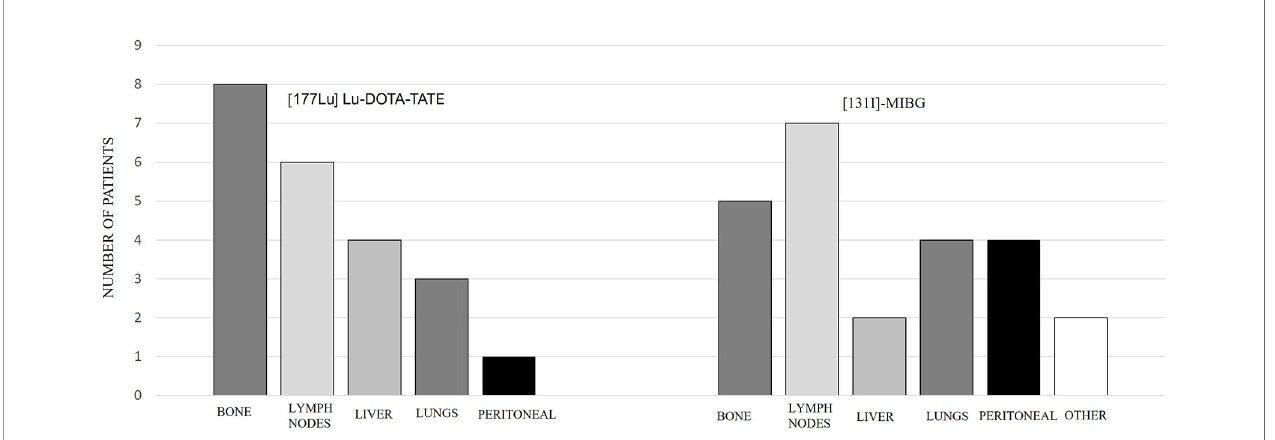
FIGURE 3 | Metastatic location in [ 177 Lu]Lu-DOTA-TATE and [ 131